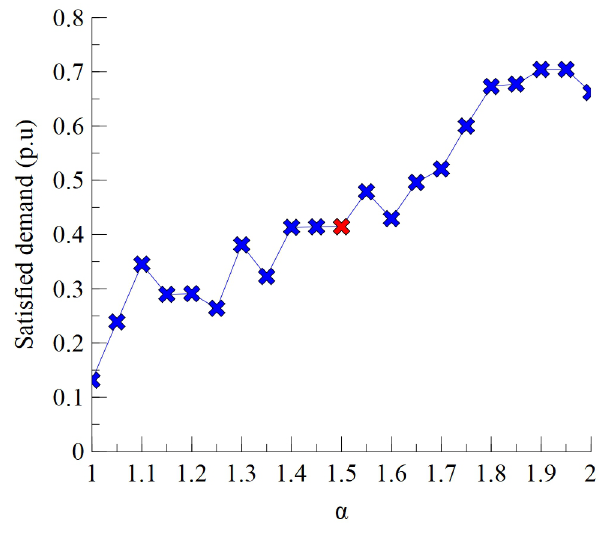
Figure 8. Overload tolerance